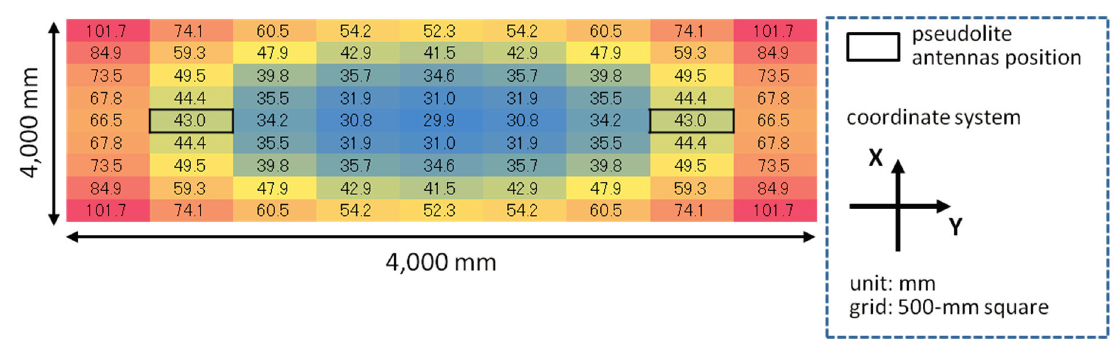
Figure 14. Three-dimensional positioning error with double array based on CPD random error (1.04